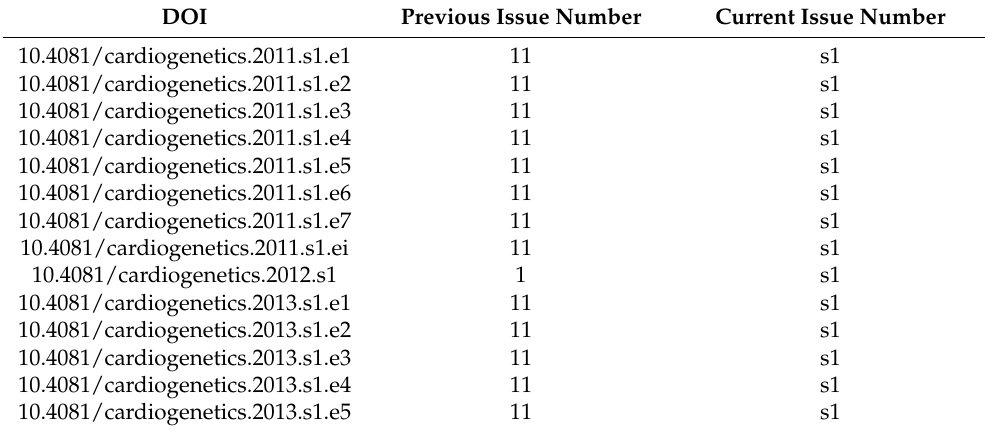
Table 2. MDPI has corrected the Issue Numbers for 14 articles originally published in Volumes